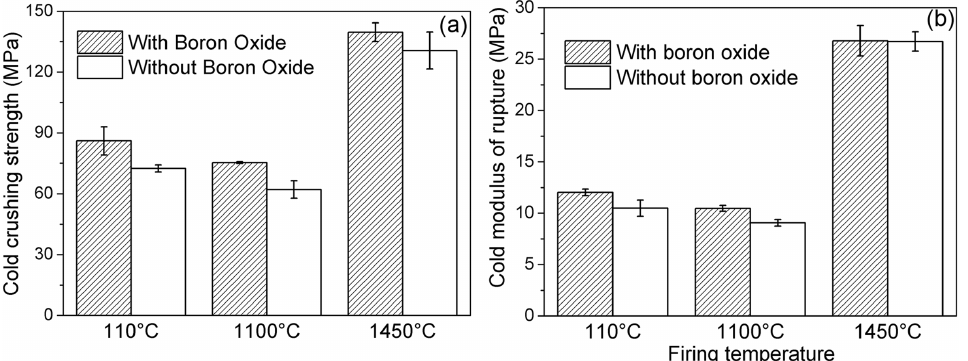
Figure 3: Cold crushing strength (a) and cold modulus of rupture (b) of castables after heat treatment at 110, 1100 and 1450°C.